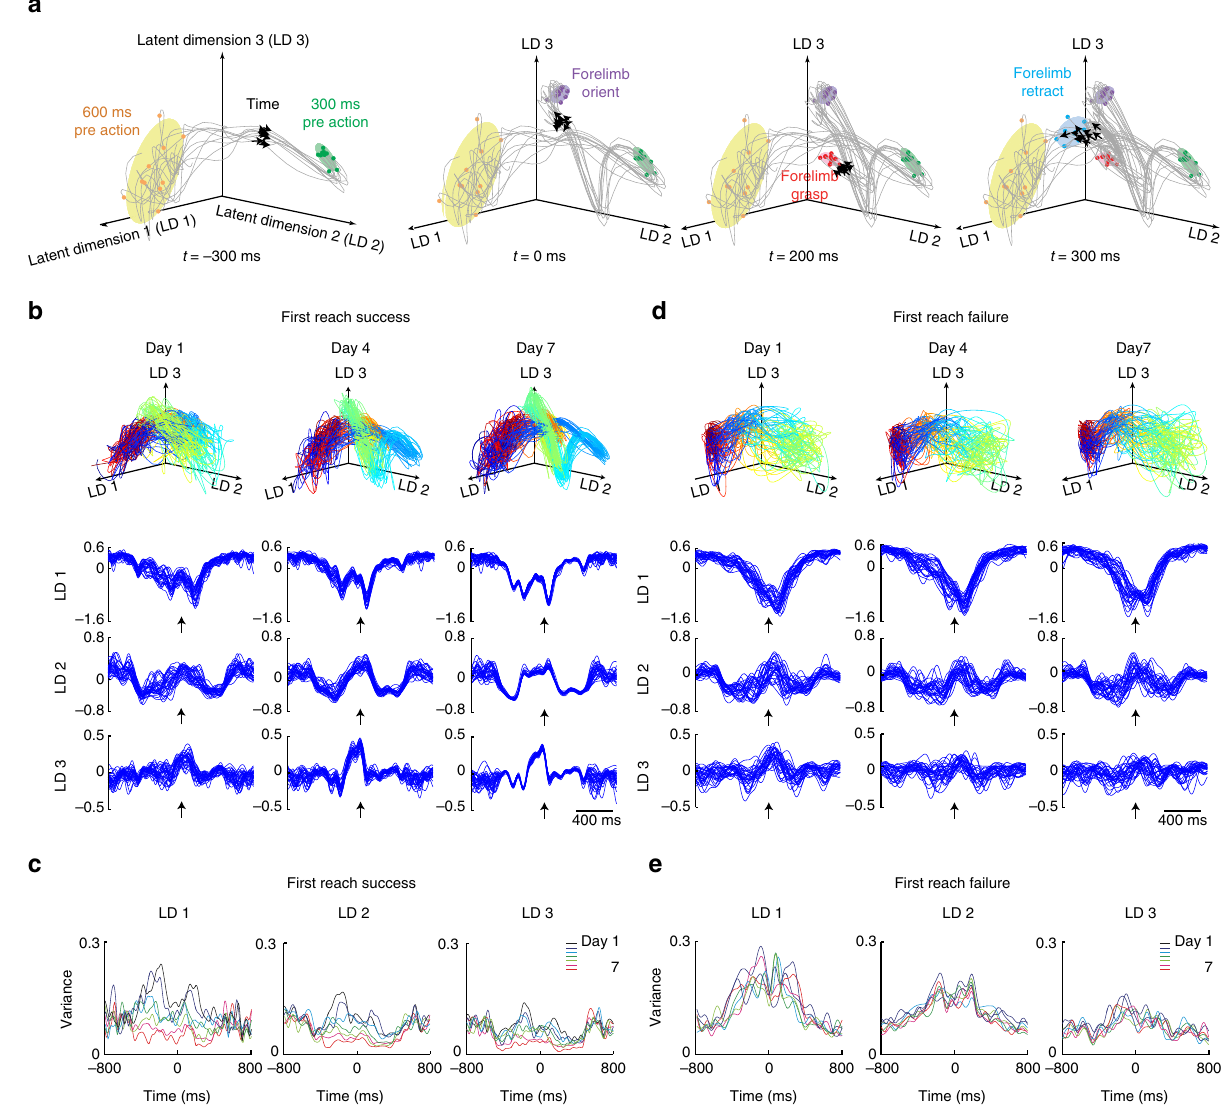
Figure 6 | Illustration of single-trial neural trajectories extracted from population neural activities. ( a ) The temporals of ten single-trial neural trajectories extracted from first reach success trials by applying GPFA (see Methods) embedded in the top three orthonormalized latent dimensional space (LD1-3) spanning from 800ms before to 800ms after the ‘orient’ position, derived from 27 L5b PNs recorded from an representative animal. The black arrows indicate the flow of time series and coloured dots denote different stages of forelimb action. The ellipses indicate the across-trial variability (two s.d. around the mean) at these states. ( b ) and ( d ) Top: Neural trajectories of 30 randomly selected first reach success trials with trajectory deviation within mean ± s.d. of cumulative Euclidean distance from reference expert trial after DTW, and neural trajectories of 30 randomly selected first reach failure trials, derived from 27 L5b PNs’ activities recorded from the same example animal. The flow of time series is colour gradient coded, from blue (start) to red (end). Bottom: the same neural trajectories shown in three individual latent dimensional space (LD1-3). Arrow indicates ‘orient’ position. ( c ) and ( e ) Analysis of the variance of the neural trajectories in LD1-3, quantified by the diagonal matrix of the covariance ellipsoids, showing progressive reduction in the variance in first reach success trials ( c ) but not in failure trials ( e ) during